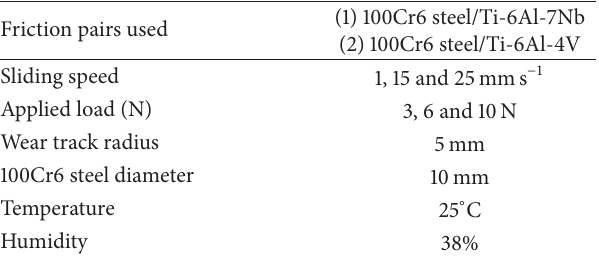
Table 2: Work condition of alternative movement wear test (oscil- lating